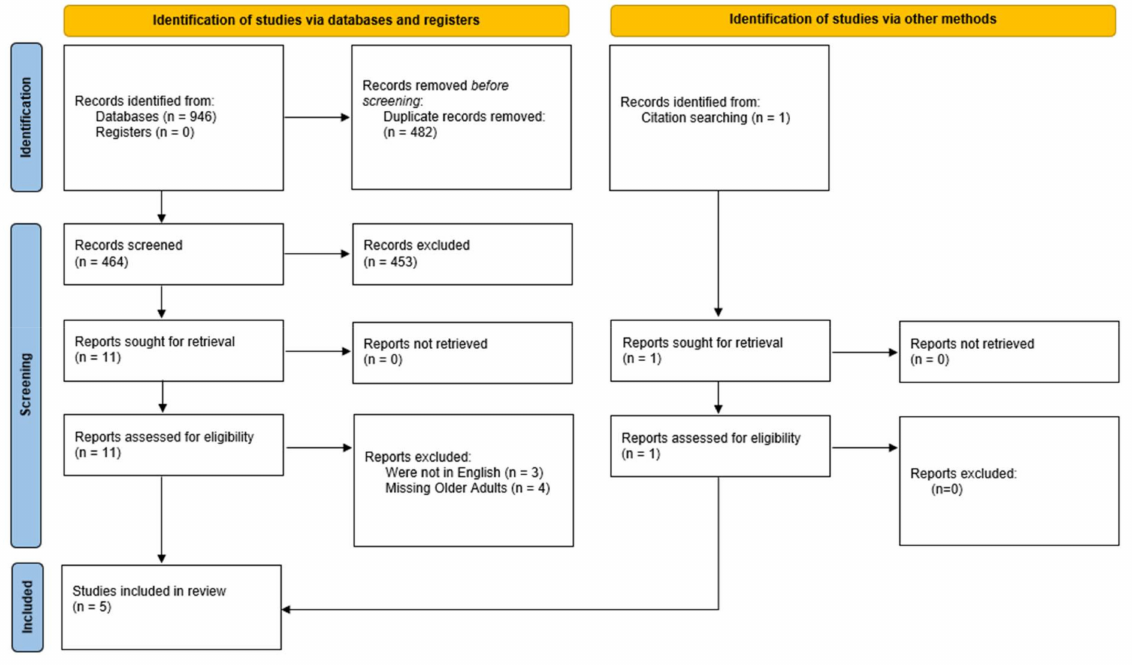
Figure 1. PRISMA